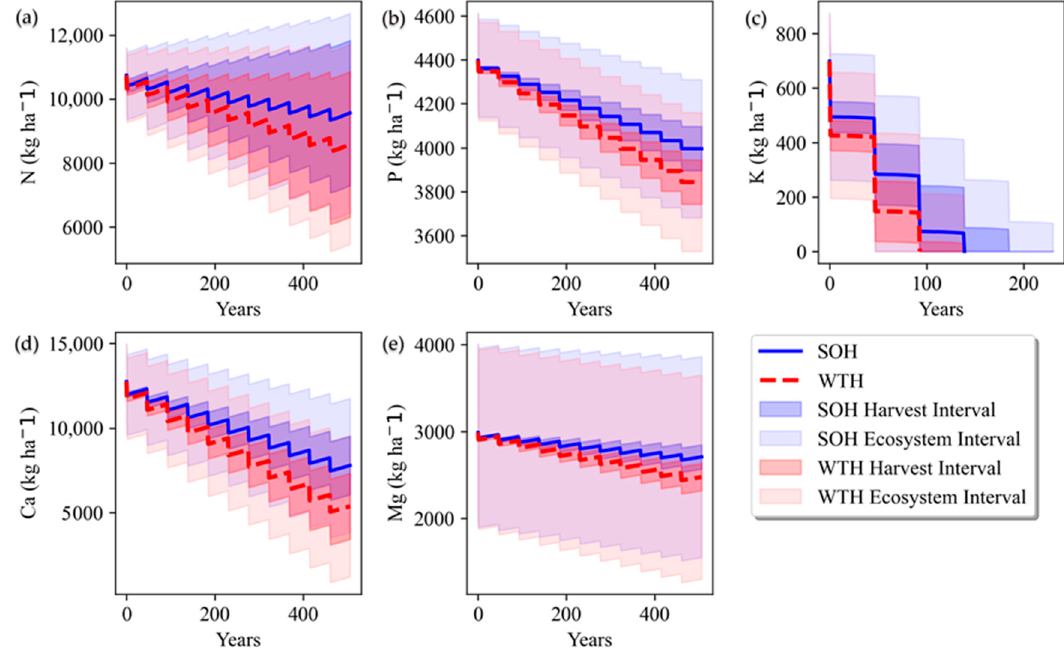
Figure 5. NCSS Alfic Haplorthods pedons by harvest simulation type with weathering rates from Warba series. ( a – e ) WTHs decreased the total number of rotations for each nutrient as compared to SOH, with large variability in the systems shown by confidence intervals ( α = 0.05), and only the K pool was depleted. ( a , b ) N, P, and Mg showed minimal impacts through WTH and SOH. ( c ) K showed depletion after 3 WTHs and 4 SOHs. ( d ) Ca showed differences between SOH and WTH halfway through the model Harvest Recovery Years.